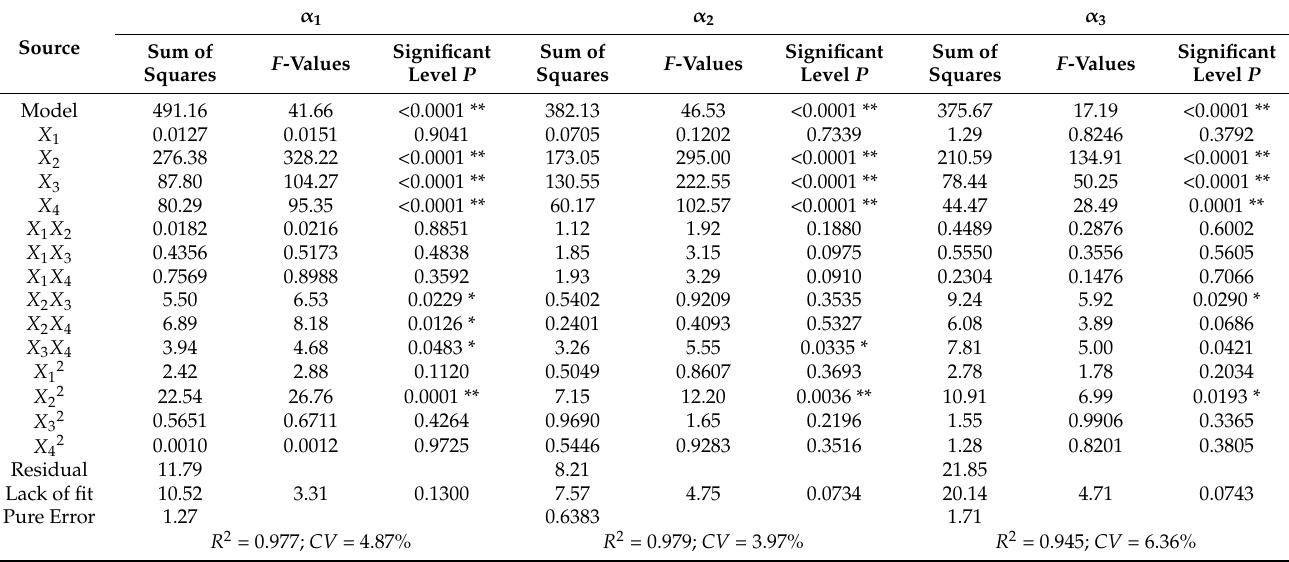
Table 7. Analysis of variance of quadratic polynomial model of the Box-Behnken design